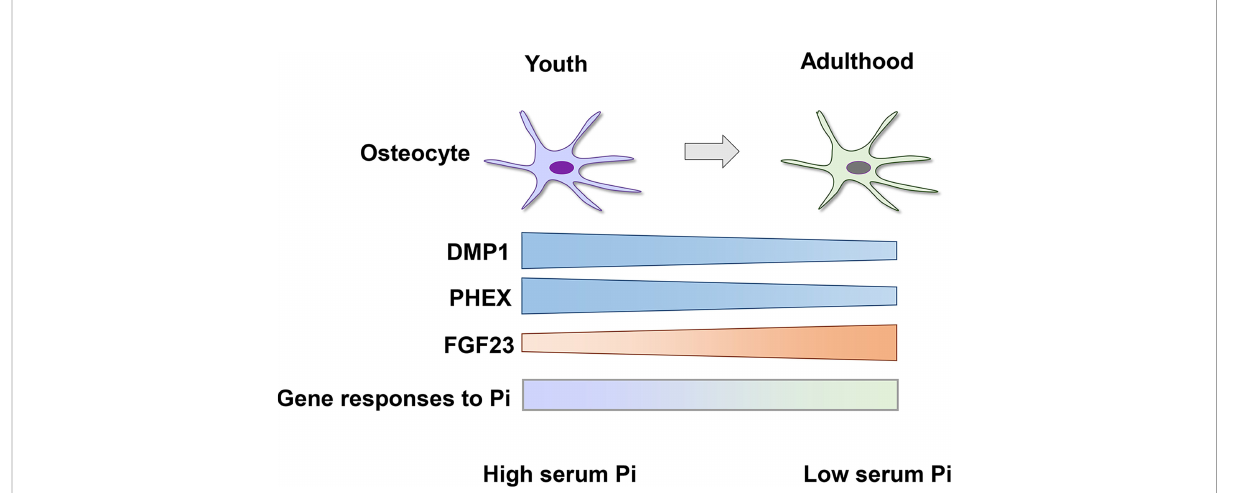
FIGURE 2 Growth-related changes in osteocytes cause a decrease in serum phosphate levels from youth to adulthood. The osteocytic expression of DMP1 and PHEX declines from youth to adulthood, which leads to an increase in the production of FGF23 and decrease in serum phosphate (Pi) levels. Gene responses of osteocytes to extracellular Pi are distinct between youth and adulthood (depicted as a shaded bar), suggesting growth-related differences in the sensitivity to the altered availability of